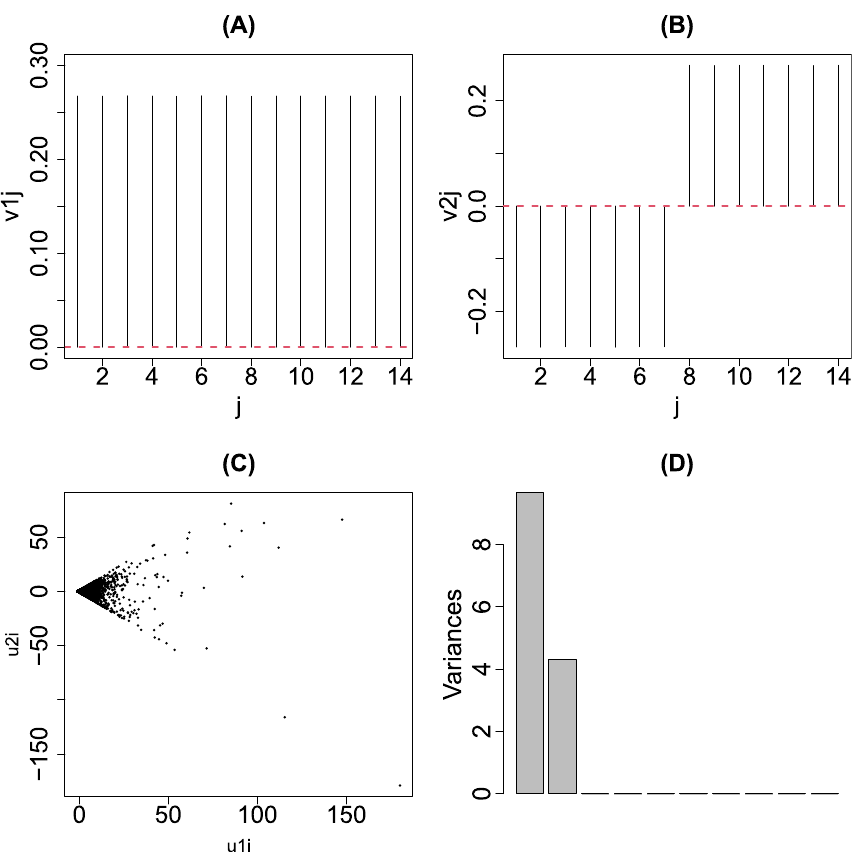
Figure 2. PCA applied to MAQC data ( A ) v 1 j ( B ) v 2 j ( C ) Scatter plot of u 1 i and u 2 i ( D ) Contributions of individual